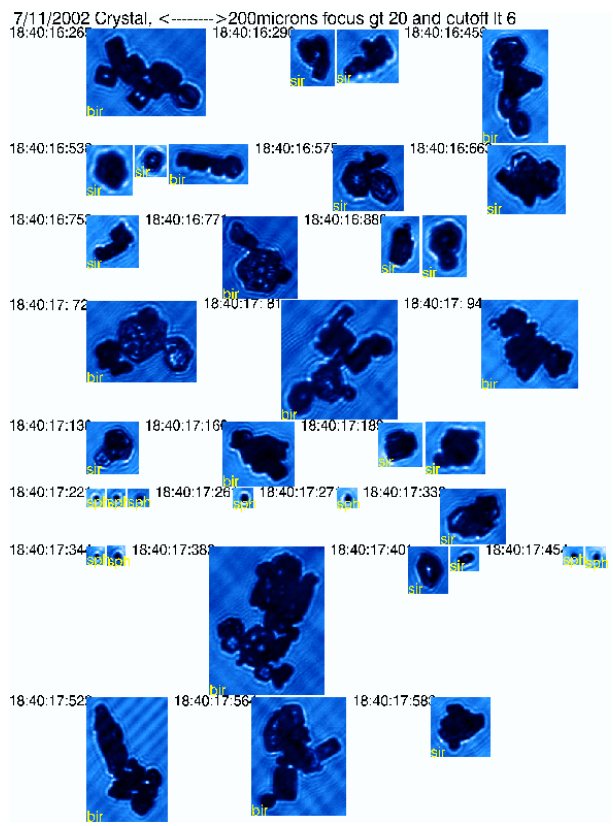
Fig. 9. Typical CPI images taken in the 11 July case on the WB-57.